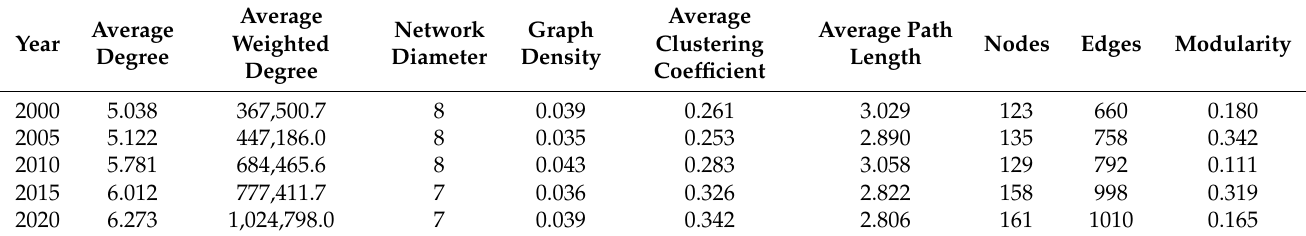
Table 2. Topology characters of the global soybean trade network (data source: results from this